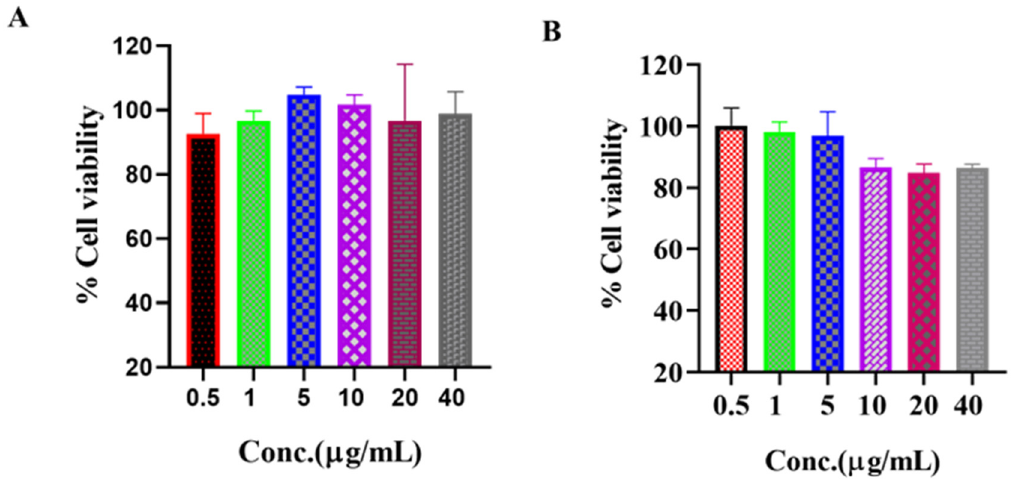
Figure 6. Cytotoxicity study on MG-63 cells. ( A ) % cell viability of PTH (1-34) and ( B ) % cell viability of PTH-LPs at different concentrations. of PTH-LPs at different